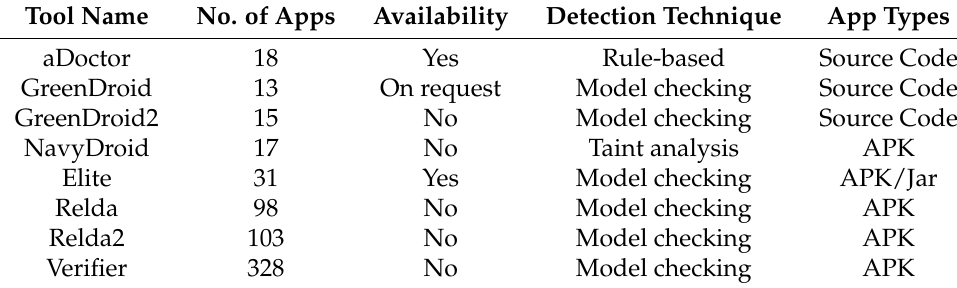
Table 1. Tools used to detect wake lock leaks.